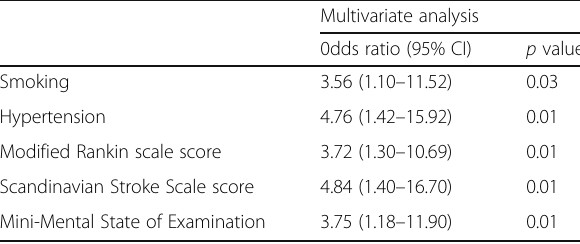
Table 4 Logistic regression model of significant risk factors associated with post-stroke